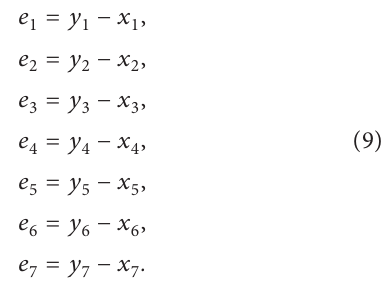
Figure 3: Phase portraits of the four stable periodic orbits at R 24 arising from a Hopf bifurcation at R e � 20 . 845 that remains stable for up to R e � 26 . 323.